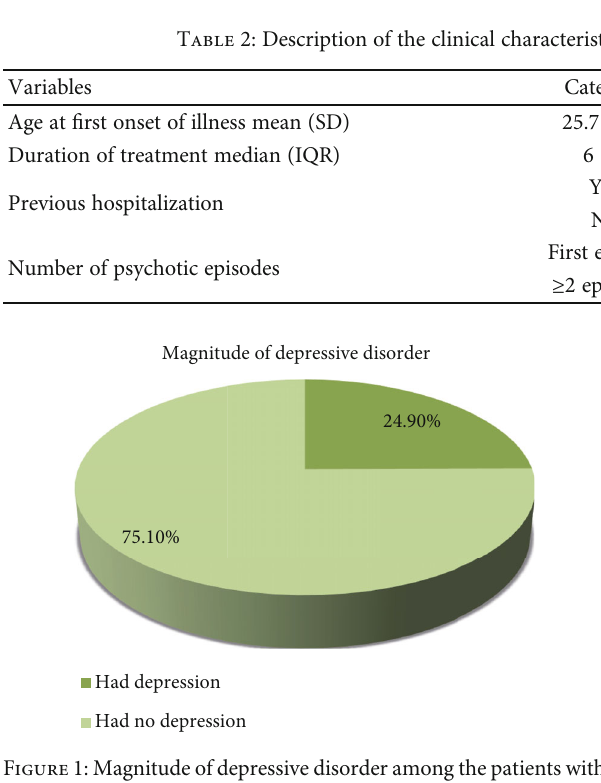
Figure 1: Magnitude of depressive disorder among the patients with schizophrenia in AMSH